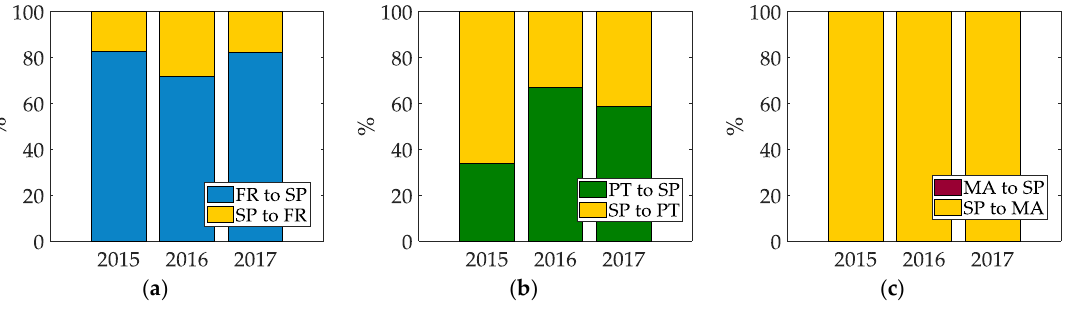
Figure 5. 2015–2017. ( a ) Annual percentages of international SP-FR energy exchanges; ( b ) annual percentages of international SP-PT energy exchanges; ( c ) annual percentages of international SP-MA energy exchanges.